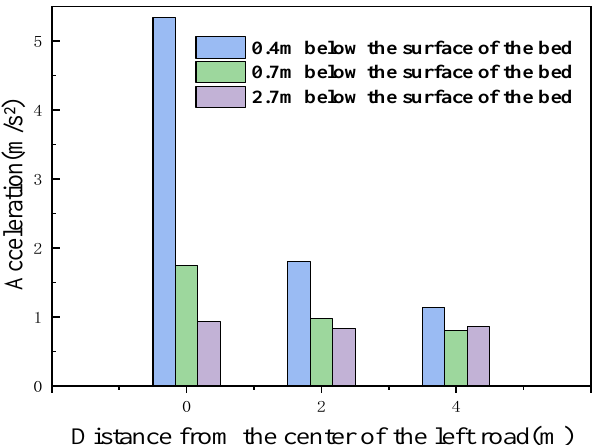
Figure 16. Distribution law for vibrational acceleration along the transverse direction.